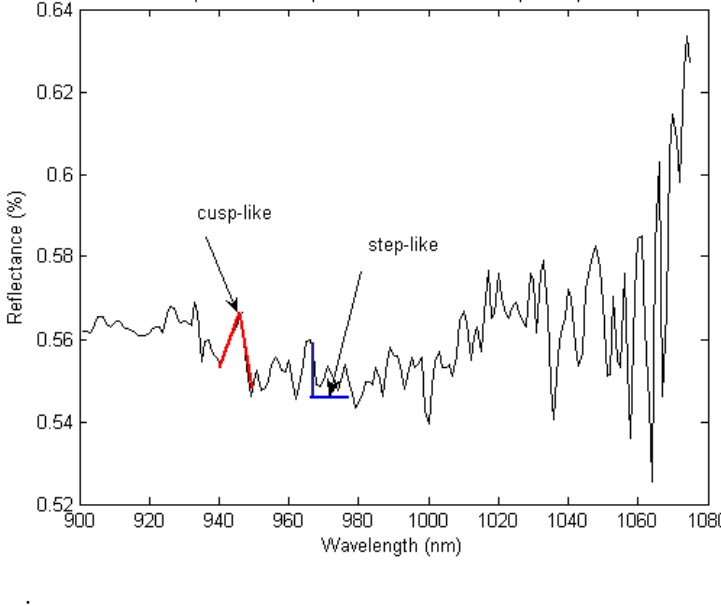
Figure 2. Heterogeneous signal of a reflectance spectrum, obtained from a potato plant, showing two types of singularities: cusp-like and step-like features, the so-called singularities in the